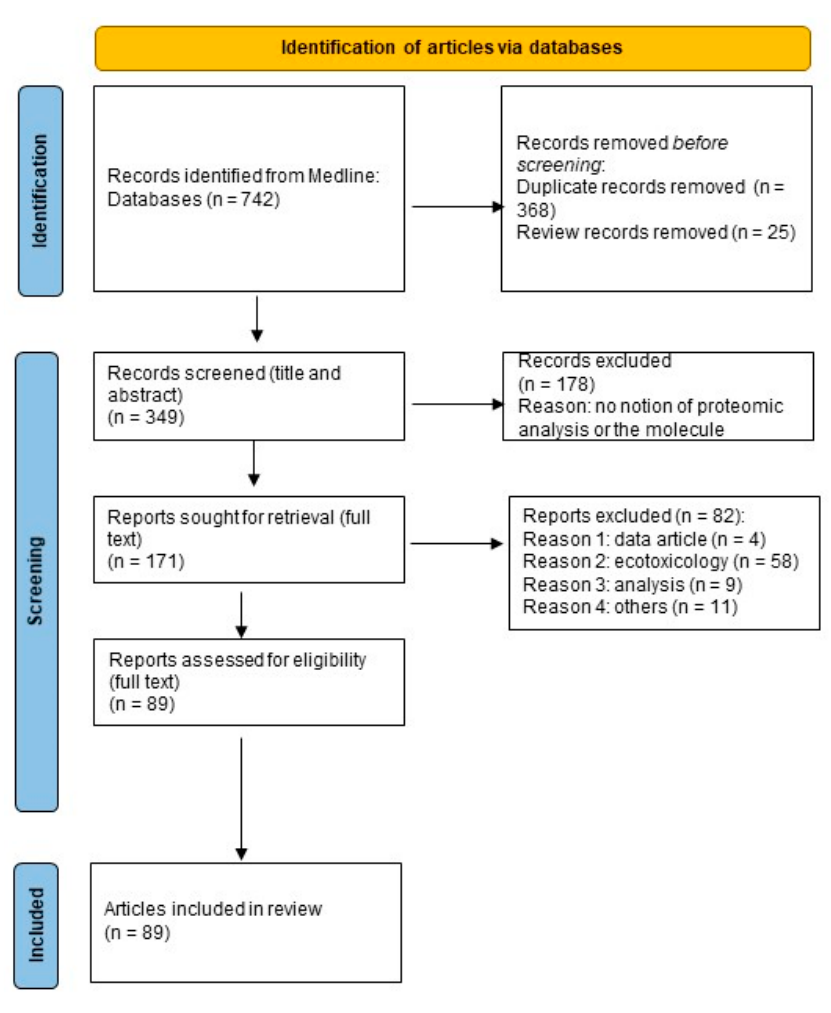
Figure 3. Flowchart of article selection.